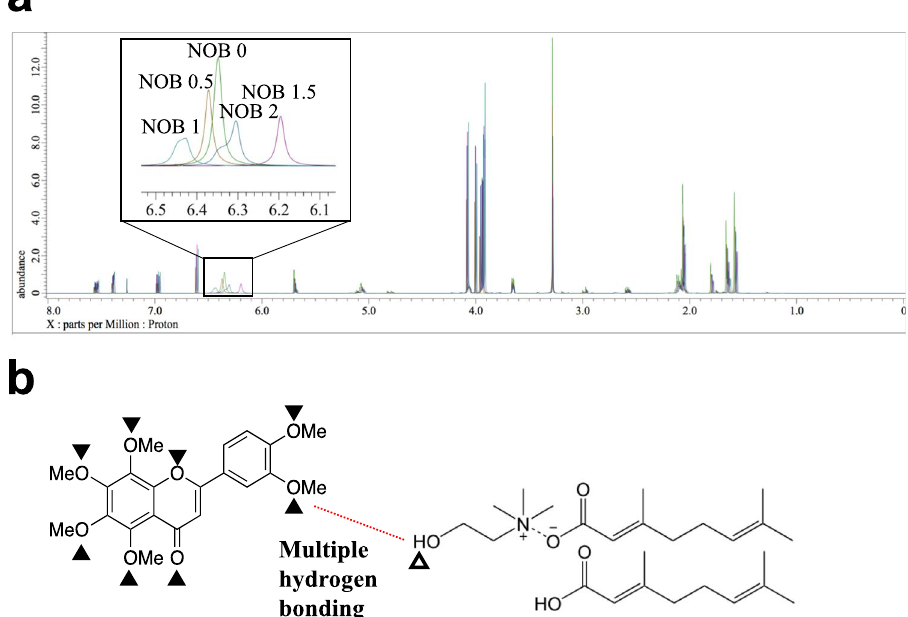
Figure 2. Overlapped 1 H NMR spectra of NOB-CAGE complexes at each molar ratio ( a ) and a schematic diagram of the interactions between NOB and CAGE ( b ). NOB was mixed with CAGE at different molar ratios [CAGE: NOB = 1:0 (NOB 0), 2:1 (NOB 0.5), 1:1 (NOB 1), 1:1.5 (NOB 1.5), and 1: 2 (NOB 2) mol/mol]. The mixtures were dissolved with chloroform- d and then analyzed by 1 H NMR. The closed triangles show the O atoms in NOB that might interact with CAGE as hydrogen bonding acceptors. The white triangle shows the H atom in CAGE that might interact with NOB as a hydrogen bonding donor.